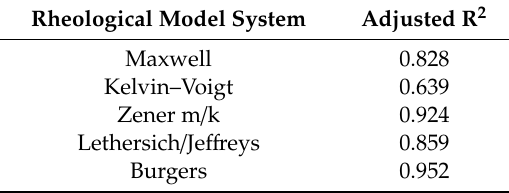
Table 12. Applicability of di ff erent model systems for PCL filled 3% ( w / v ) alginate solution.